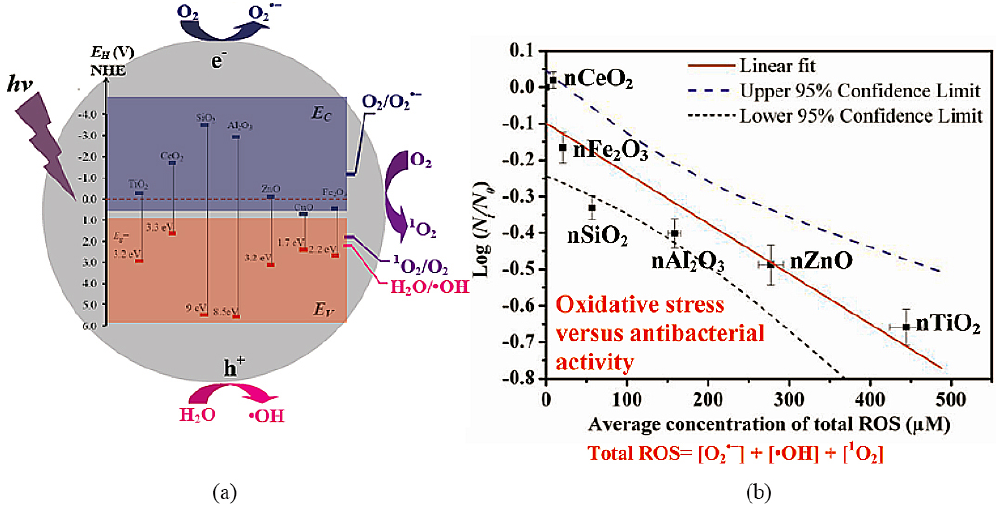
Figure 2. Mechanism of photogenerated ROS ( a ); and correlation with the antibacterial properties of metal-based NPs ( b ) (reproduced with permission from [29], Copyright American Chemical Society, 2012).